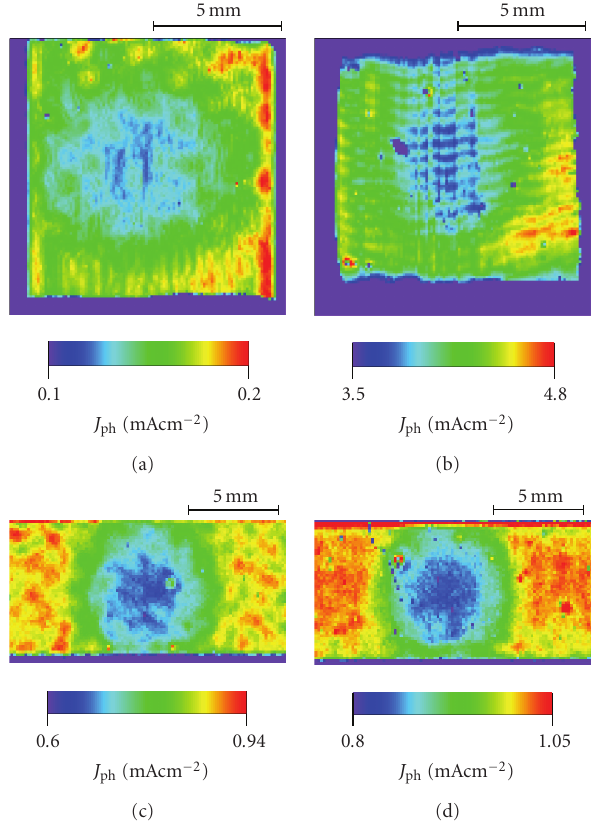
Figure 4: Photodegradation in photocurrent images of four regularly operating nanocrystalline TiO 2 solar cells. Sensitization with N3-dye and illumination with simulated solar light in a round central areas only. Illumination periods: (a) 1008 hours; (b) 336 hours; (c) 1248 hours; (d) 1248 hours.